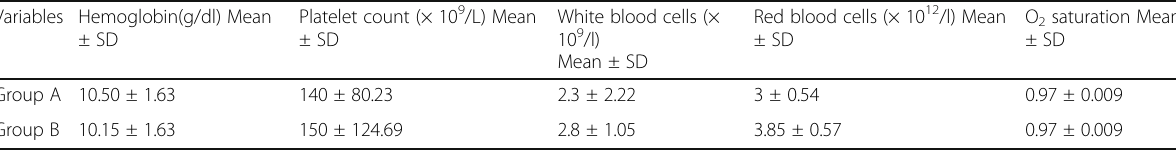
Table 3 Medical characteristics of the patients in both groups Variables Hemoglobin(g/dl) Mean ± SD